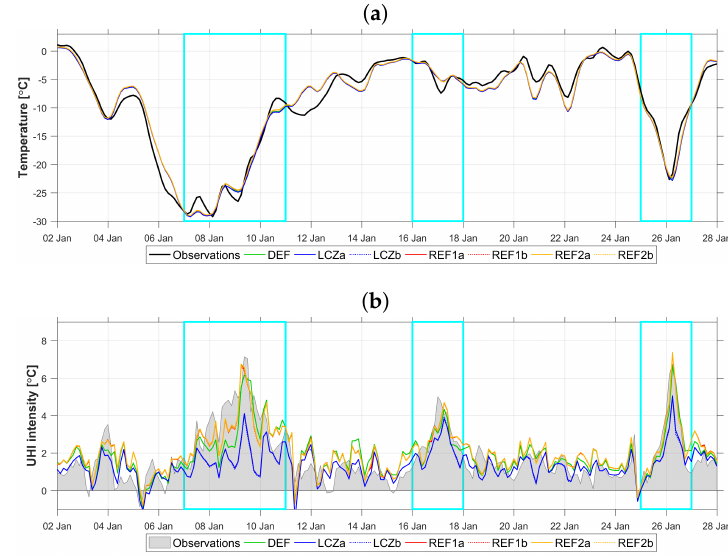
Figure 12. Modelled and observed time series of the mean rural temperature and UHI intensity for the period in January 2017. Cyan rectangles indicate the sub-periods selected for the analysis of the diurnal and spatial variations of the temperature and UHI intensity. ( a ) Mean rural temperature; ( b ) UHI intensity (city centre, Balchug WS).